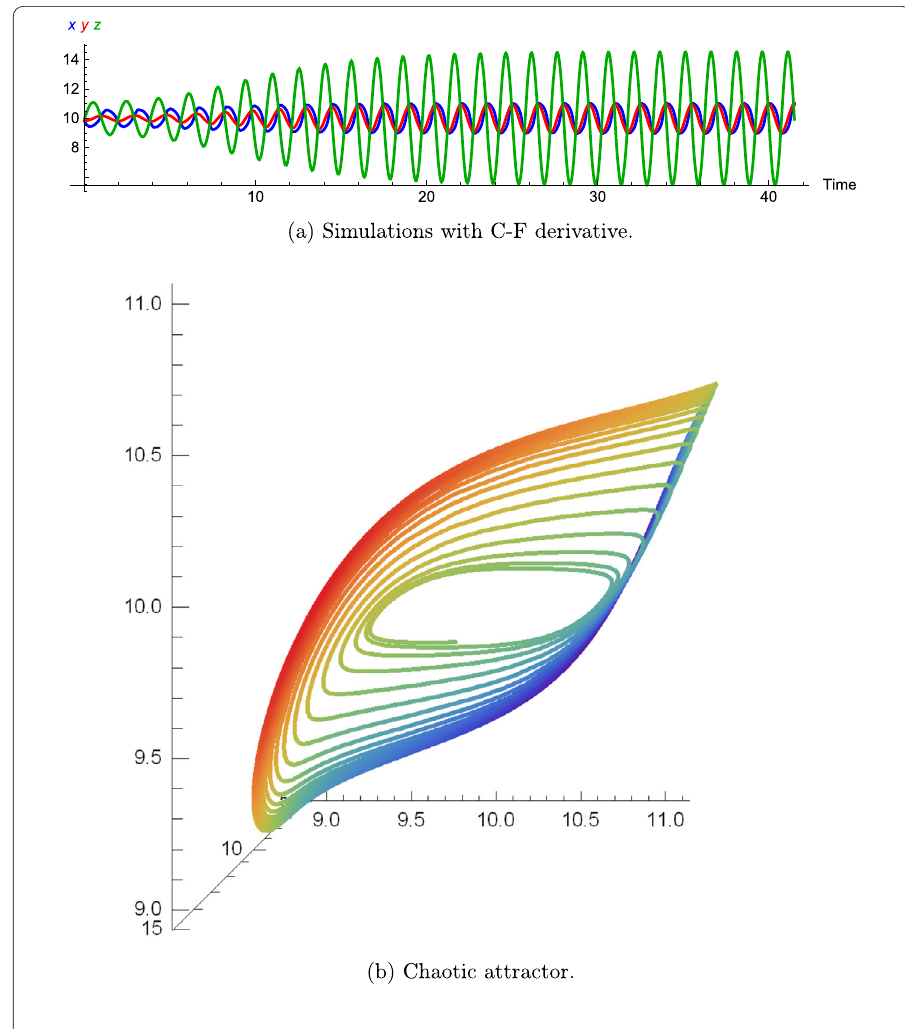
Figure 3 OPIM – CF solutions of the modified Chua’s circuit in Example